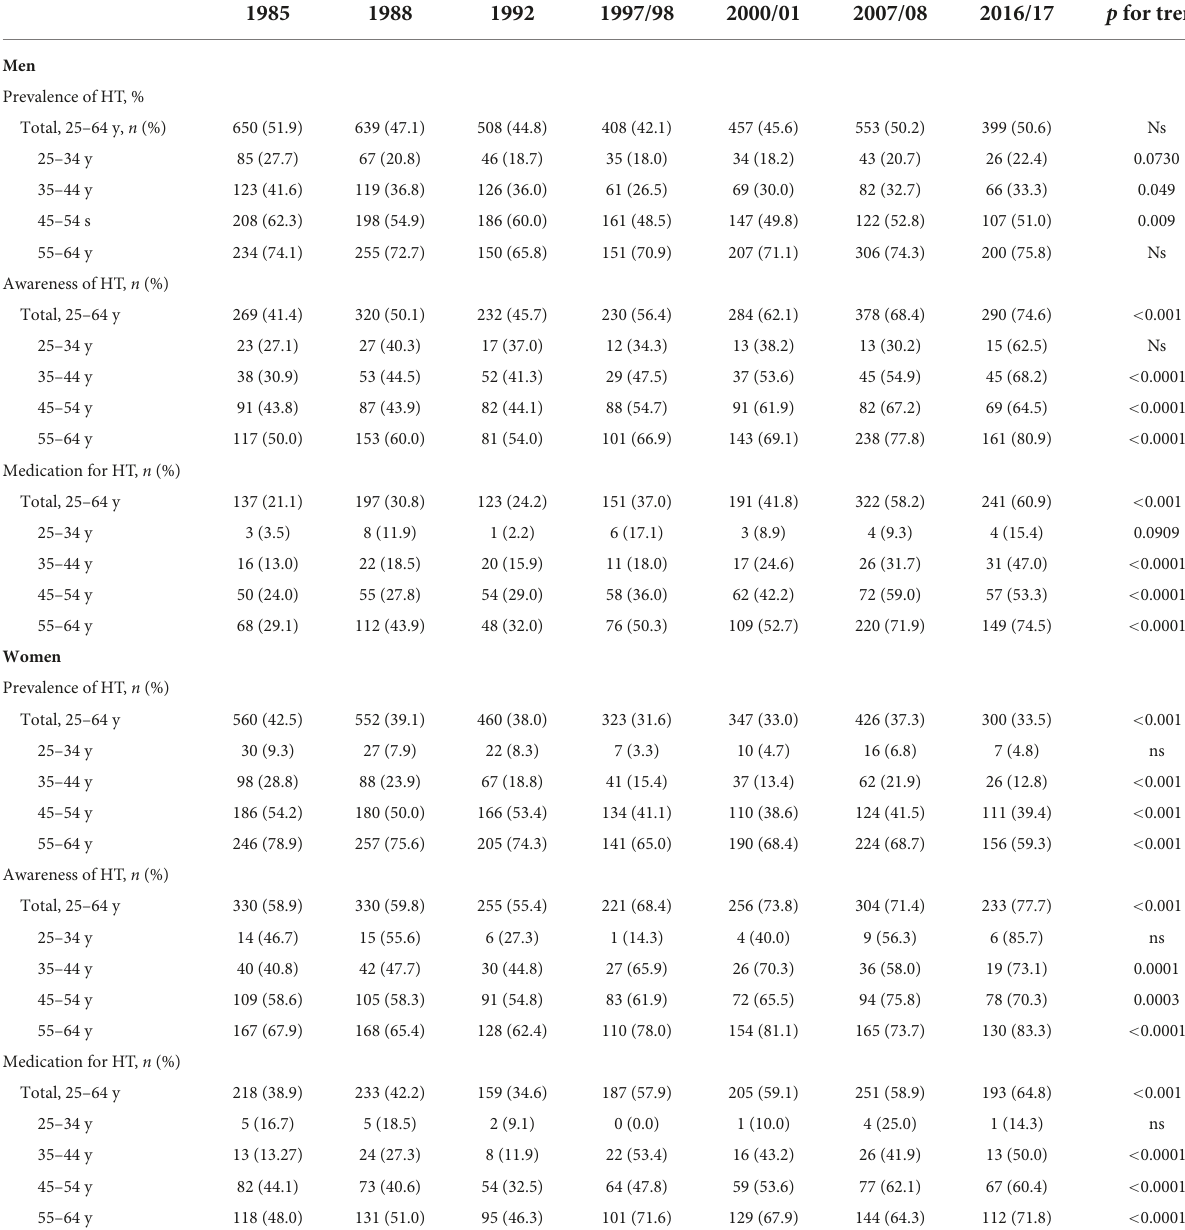
TABLE 3 Prevalence, awareness, and treatment of hypertension between 1985 and 2016/17 in six districts of the